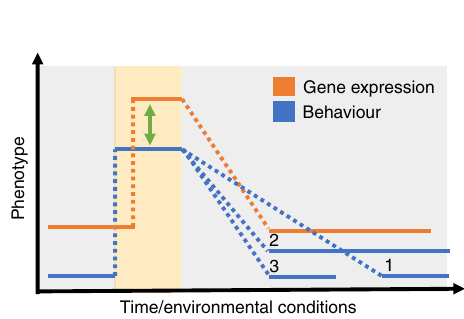
Fig. 3 Gene expression and behavioural dynamics are understudied, but may provide insights into other levels of organization that in fl uence behaviour. Changes in phenotype in response to a transient shift in environmental conditions (grey vs. beige) is indicated as an increase in gene expression and behaviour. In this fi gure, we arbitrarily chose to show the direction of change for both phenotypes as an increase. The direction of any given behavioural change is context-dependent, and for many behaviours, genes show changes in expression in both directions (notably some genes, e.g., immediate early genes, commonly increase in expression 22 ). The green arrow indicates the potential interaction between behaviour and gene expression. Hypothetical outcomes of this interaction (blue lines 1 – 3) are discussed in Box